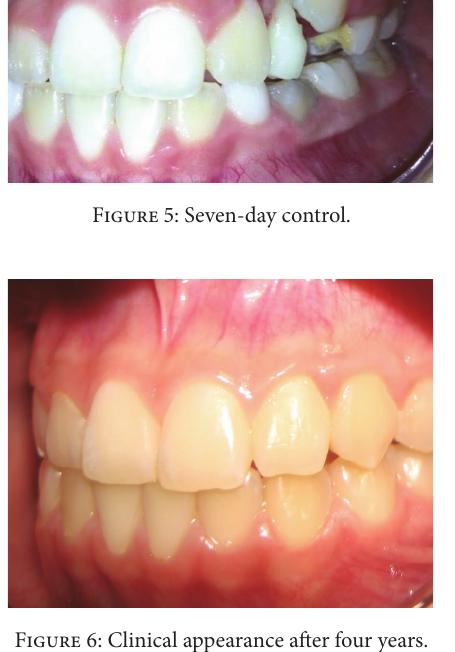
Figure 6: Clinical appearance after four years.